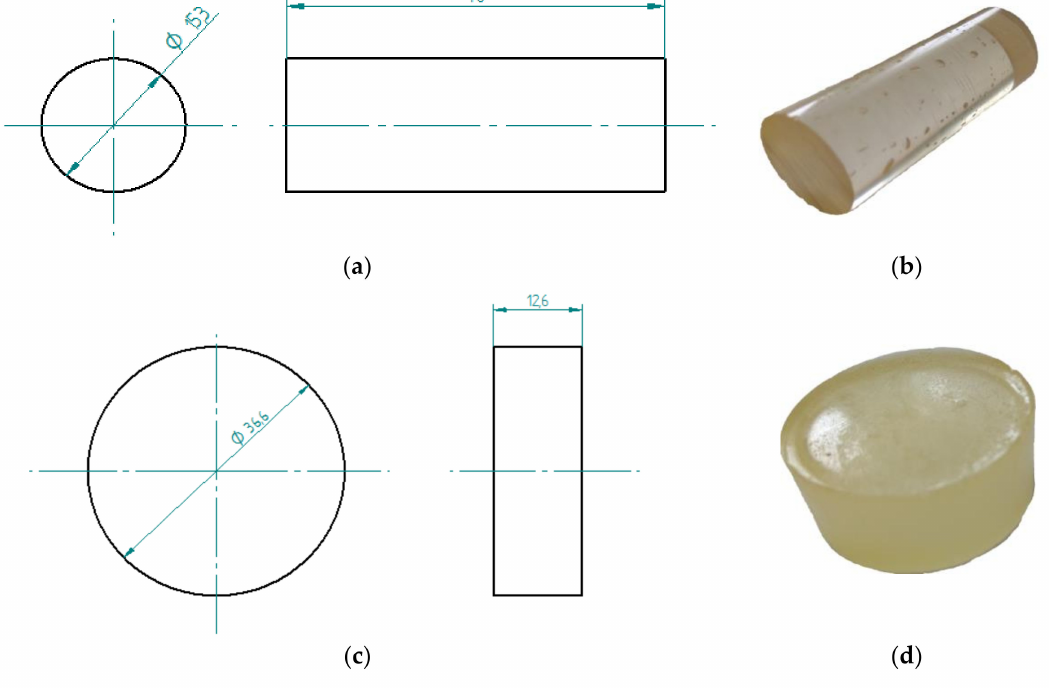
Figure 1. Epoxy compound samples: ( a ) the sample’s scheme and dimensions (in mm) for strength tests, ( b ) a view of the sample made of Epidian 53 / Z-1 for strength tests, ( c ) the sample’s scheme